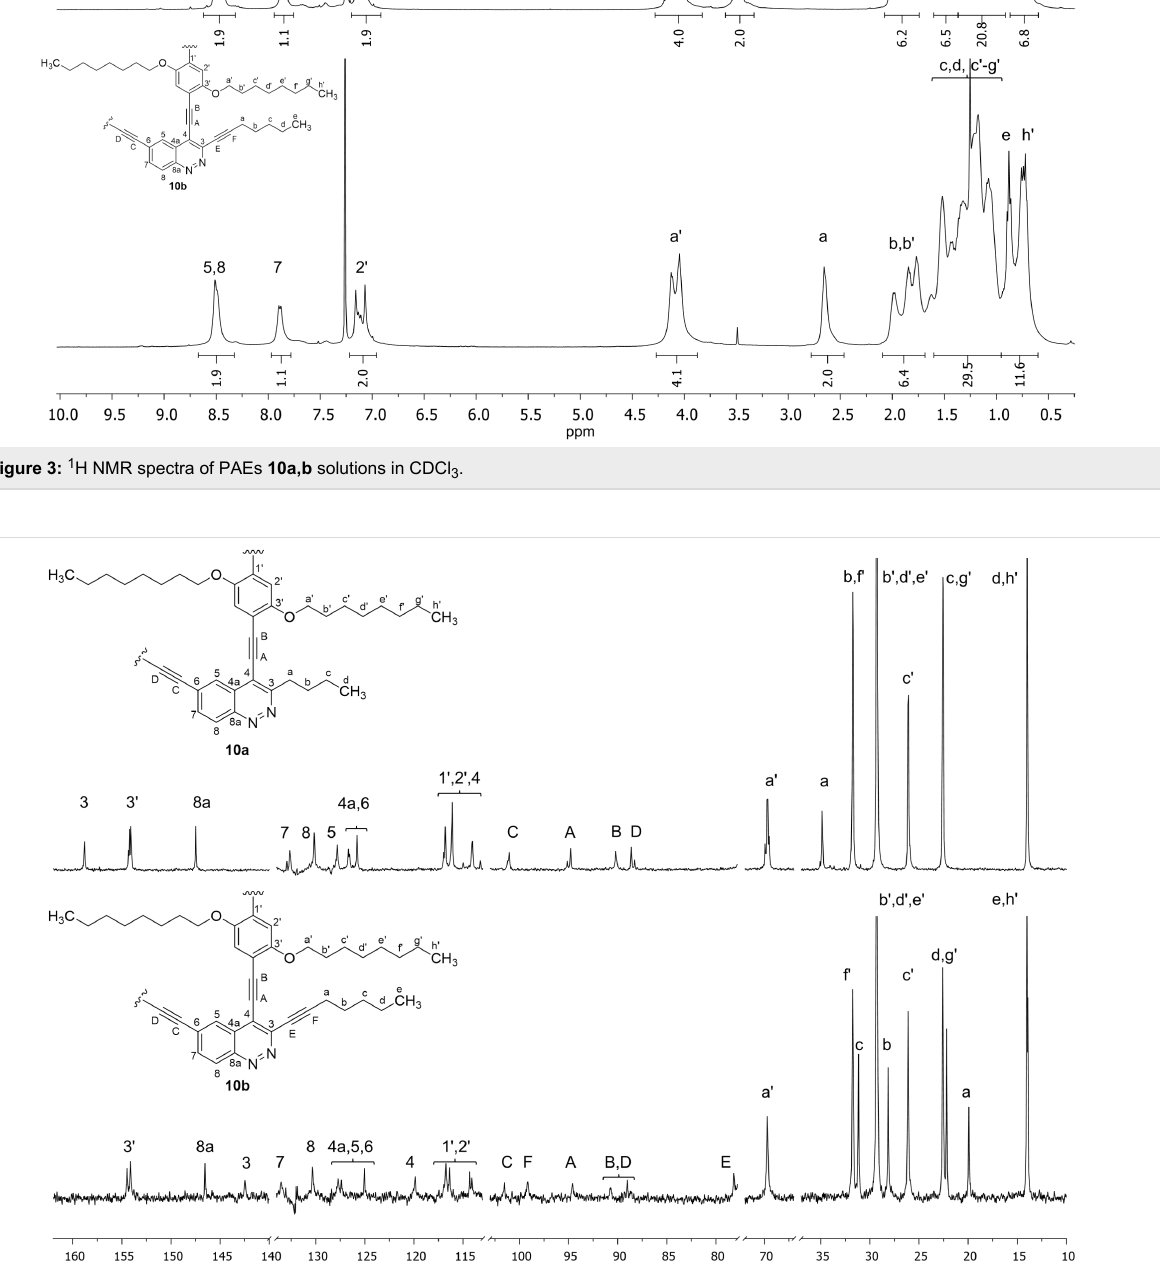
Figure 4: 13 C NMR spectra of PAEs 10a,b solutions in CDCl 3